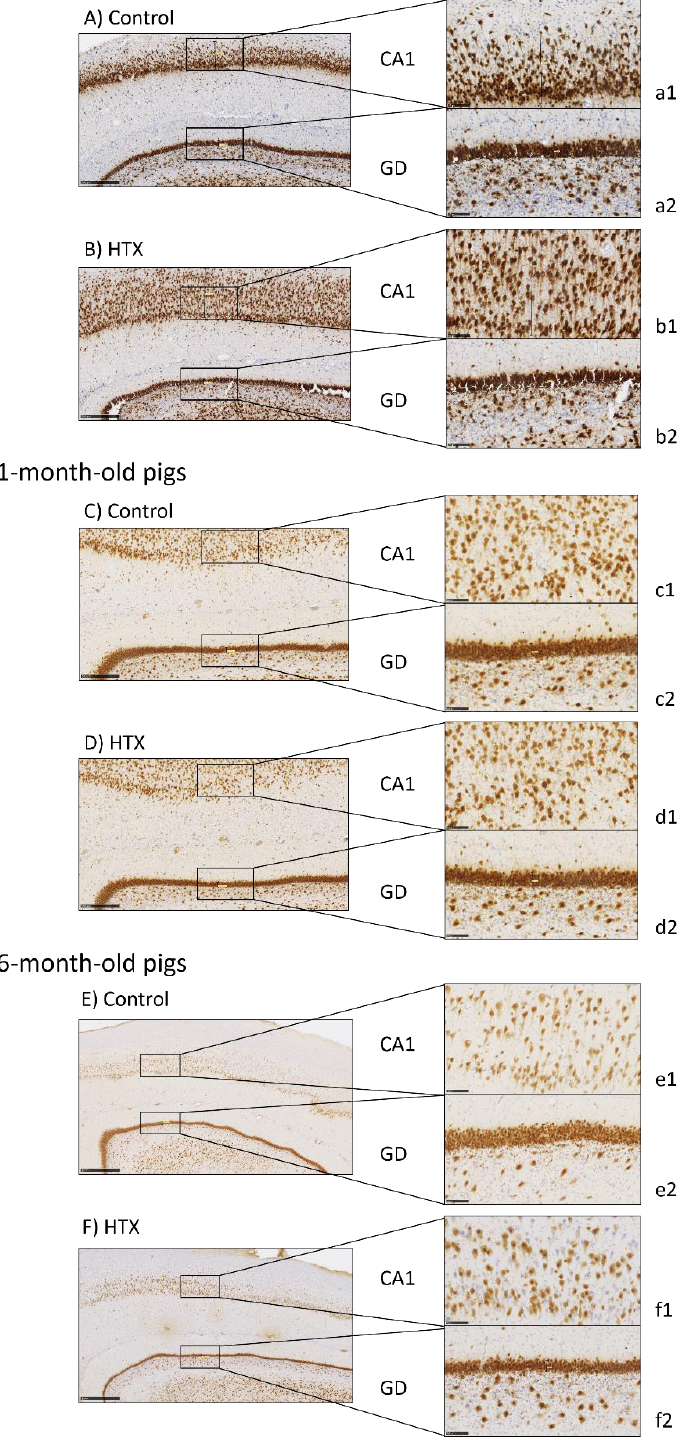
Figure 2. Effect of maternal supplementation with HTX on NeuN immunostaining on the hippocampus of 100-day-old fetuses ( A , B ) and 1-month-old ( C , D ) and 6-month-old pigs ( E , F ). Representative images show the mature neurons immunostained with the NeuN antibody, where their mothers were in the control group or supplemented with HTX. Panels are magnifications of the CA1 (a1–f1) and GD (a2–f2) areas shown using black boxes. Scale bars: 1000 µm ( E , F ), 500 µm ( A – D ), and 100 µm (a1–f1, a2–f2).